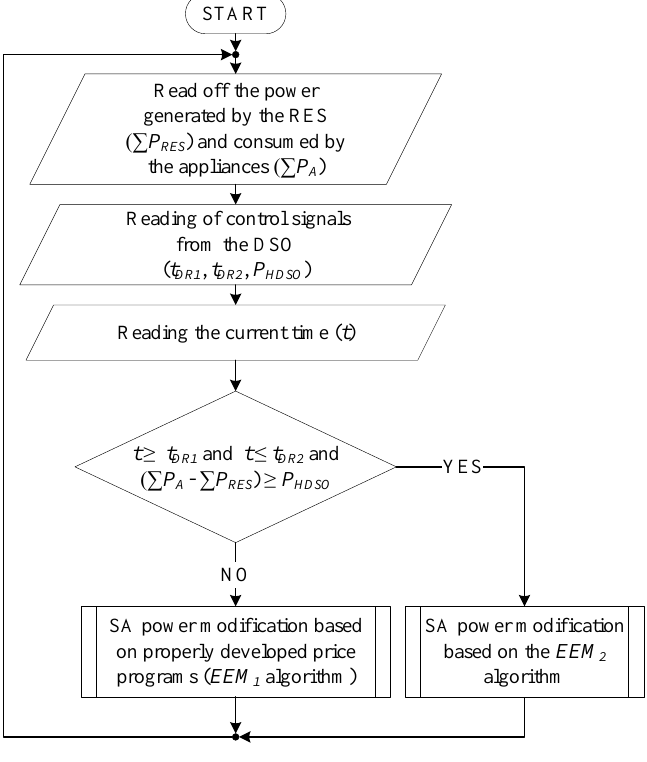
Figure 2. Flowchart of the EEM